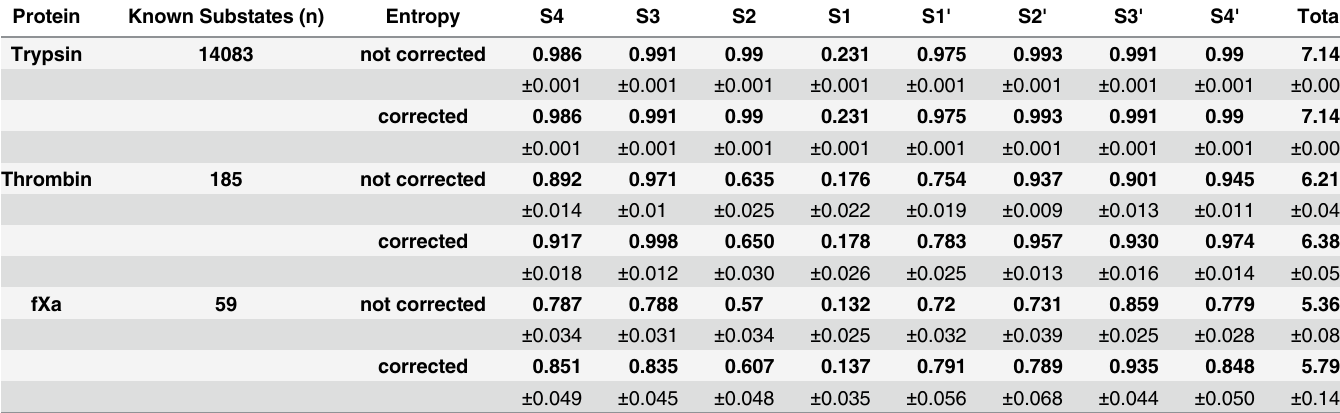
Table 1. Na ï ve and extrapolated cleavage entropies for Trypsin, Thrombin and Factor Xa: The cleavage entropies for these three proteases are given for the 8 subpockets S4-S4 ’ and the total (sum) cleavage entropy. Data from MEROPS (9.12). Protein Known Substates